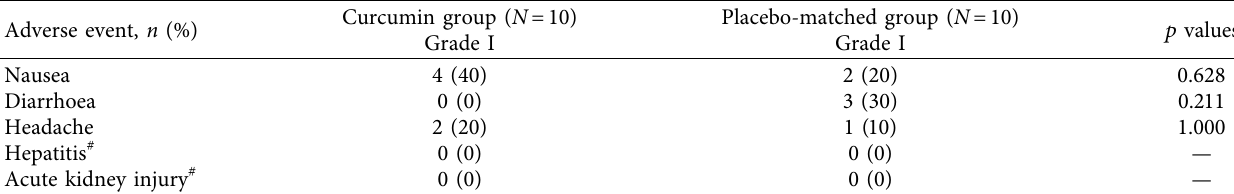
Figure 3: Comparison between the secondary outcomes on the percentage of mean change in handgrip strength, body mass index, and absolute lymphocyte count between the curcumin and placebo groups, ∗ statistically significant ( p < 0 . 05). Table 4: Summary of adverse